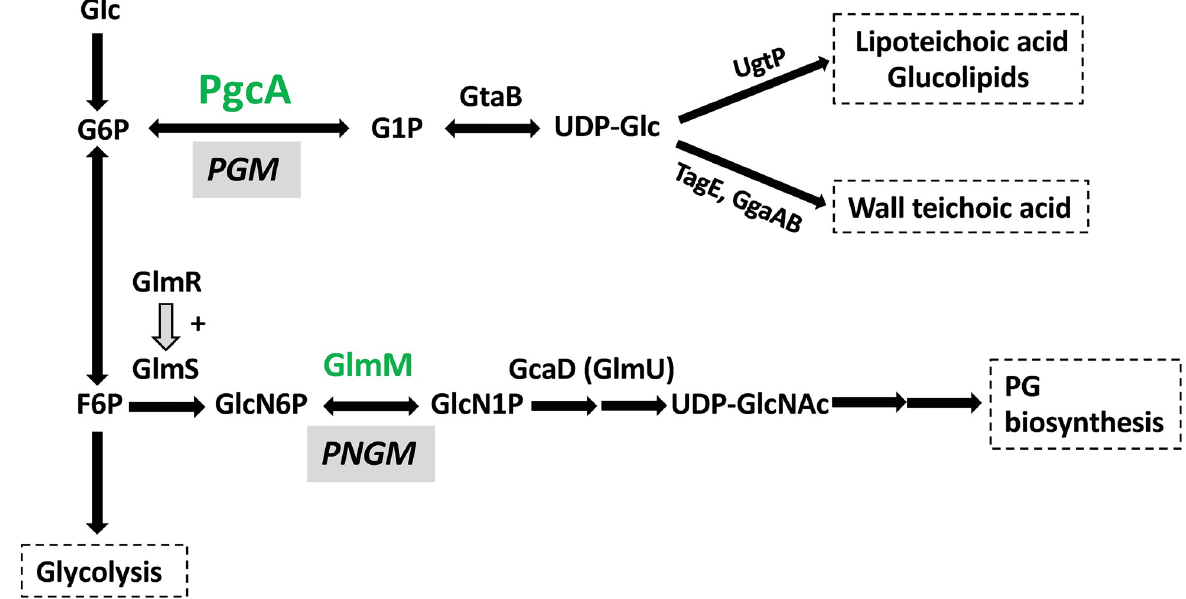
Fig 1. Schematic depicting the roles of PGM and PNGM enzymes in B . subtilis . Phosphoglucomutase ( PGM) functions in glucolipid, lipoteichoic acid, and wall teichoic acid biosynthesis. In B . subtilis , PGM activity is provided by PgcA. Peptidoglycan synthesis requires phosphoglucosamine mutase (PNGM) activity. GlmM functions as a PNGM and is an essential enzyme for peptidoglycan biosynthesis.